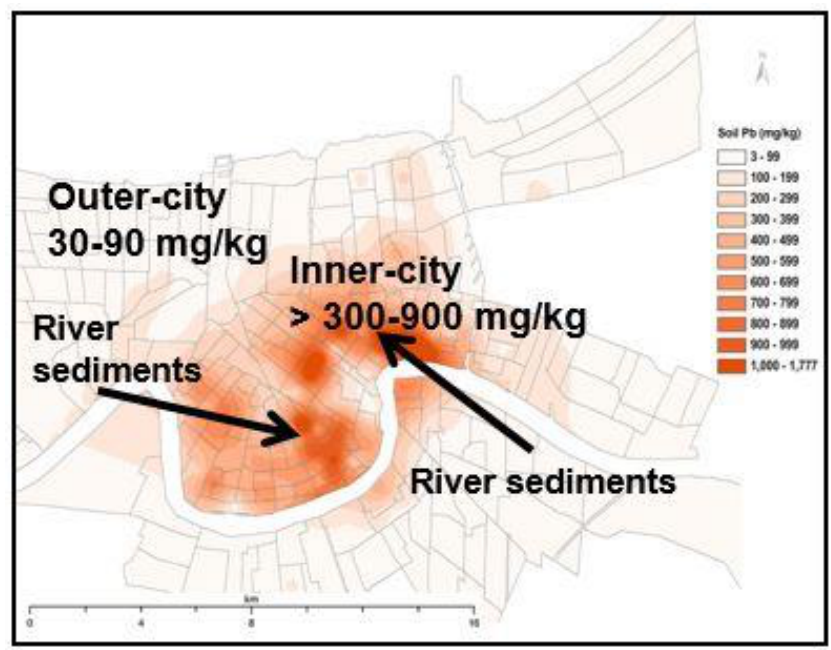
Figure 4. The dynamic changes experienced before and after Hurricane Katrina indicate that a surface covering of low lead (~5 mg/kg) alluvial sediment on lead contaminated communities is translational as a feasible and cost-effective method for reducing children’s lead exposure.